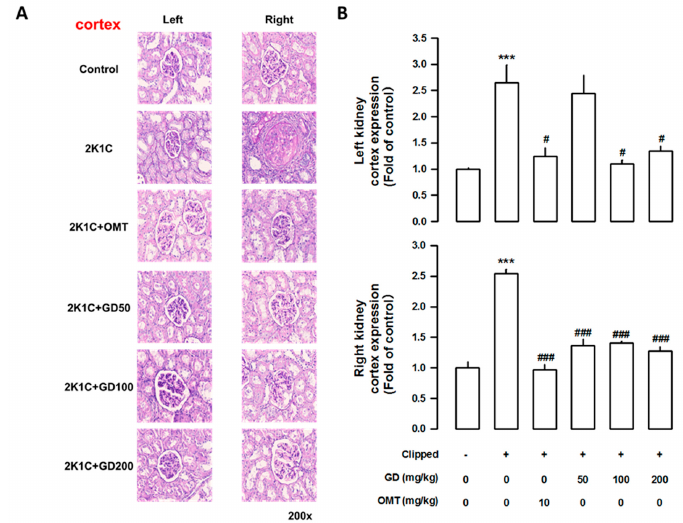
Figure 7. Effect of Gynura divaricata ( L .) DC (GD) on fibrosis in the kidney tissue. ( A ) Periodic acid-Schiff (PAS) staining in the kidney cortex (magnification × 200); ( B ) Quantitative assessments representing the results of five independent experiments. The values are expressed as the mean ± standard error ( n = 5 per group). *** p < 0.001, vs. CONT and # p < 0.05, ### p < 0.0001 vs. 2K1C.